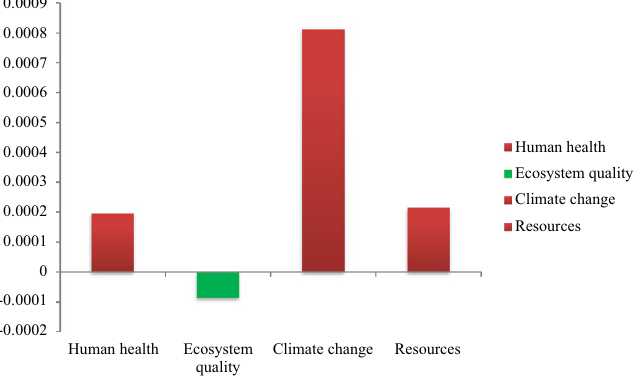
Figure 3. Normalized values of different PBS edible insect damage categories.